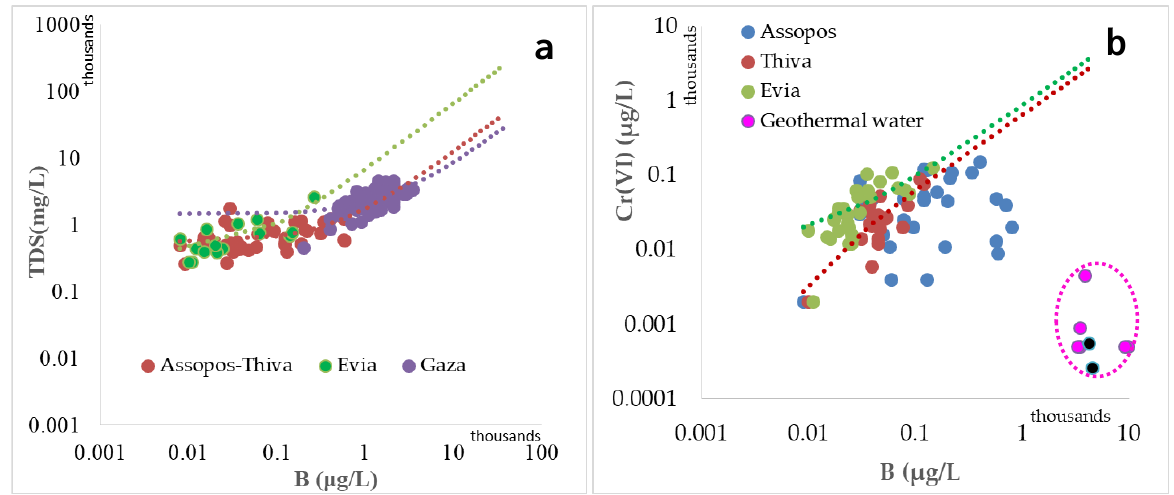
Figure 4. Plots of the Cr(VI) and total dissolved solids (TDS) versus B concentrations ( a , b ) for coastal groundwater from C. Evia, Assopos, and Thiva basins, seawater, and geothermal water. Data from [25,64,65,82–84].